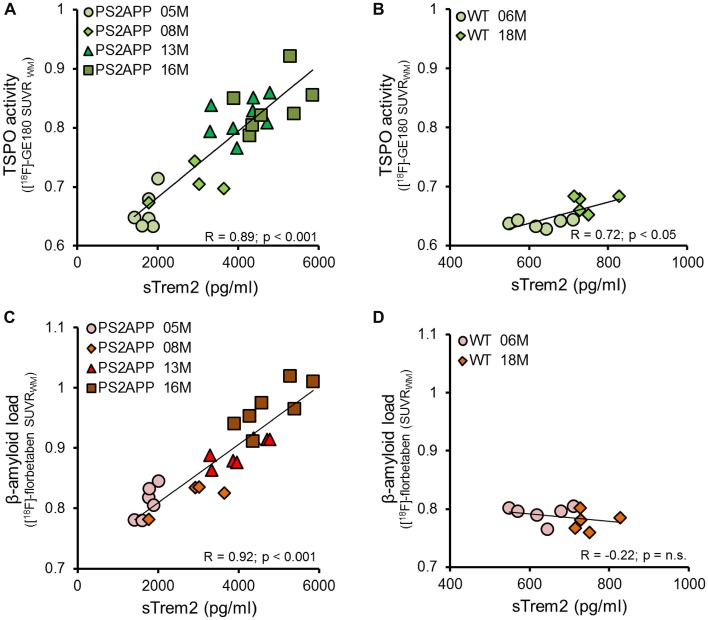
sTREM2 levels strongly correlate with dual tracer μPET in vivo measurements of TSPO and amyloidosis. (A,B) Correlation of post mortem levels of sTREM2 in the forebrain with in vivo TSPO [18F]-GE180 μPET measurements in PS2APP and WT mice. (C,D) Correlation of post mortem levels of sTREM2 in the forebrain with in vivo amyloid [18F]-florbetaben μPET measurements in PS2APP and WT mice. Data information: for all data Pearson’s coefficient of correlation (R) was calculated together with the significance level using SPSS.